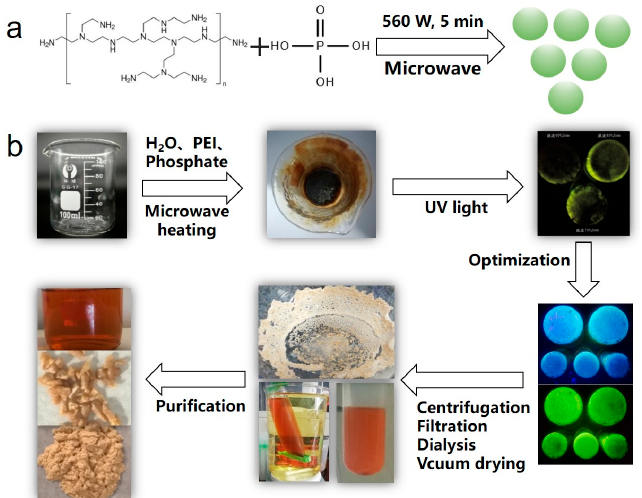
Scheme 1. Synthetic paths of RTPL materials. Schematic illustration of procedures for the prepara-